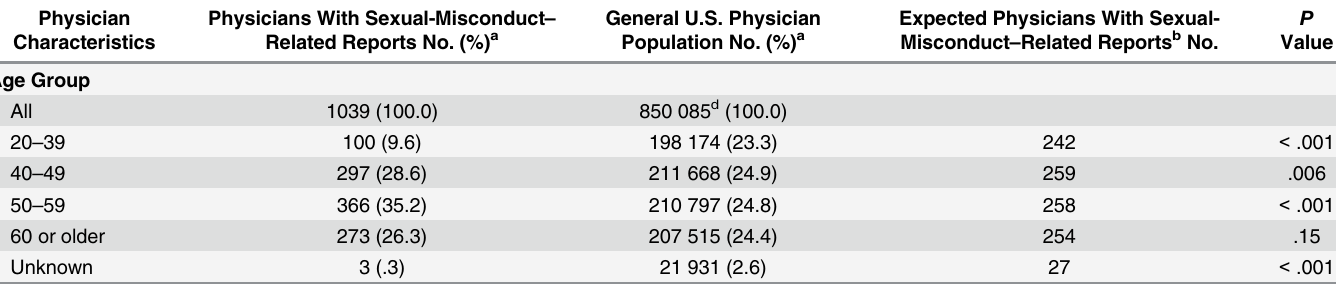
Table 2. Comparison of Age Group Distribution of Physicians With Sexual-Misconduct – Related Reports during the Study Period With the U.S. General Physician Population (Physician-Level Analysis). Physician